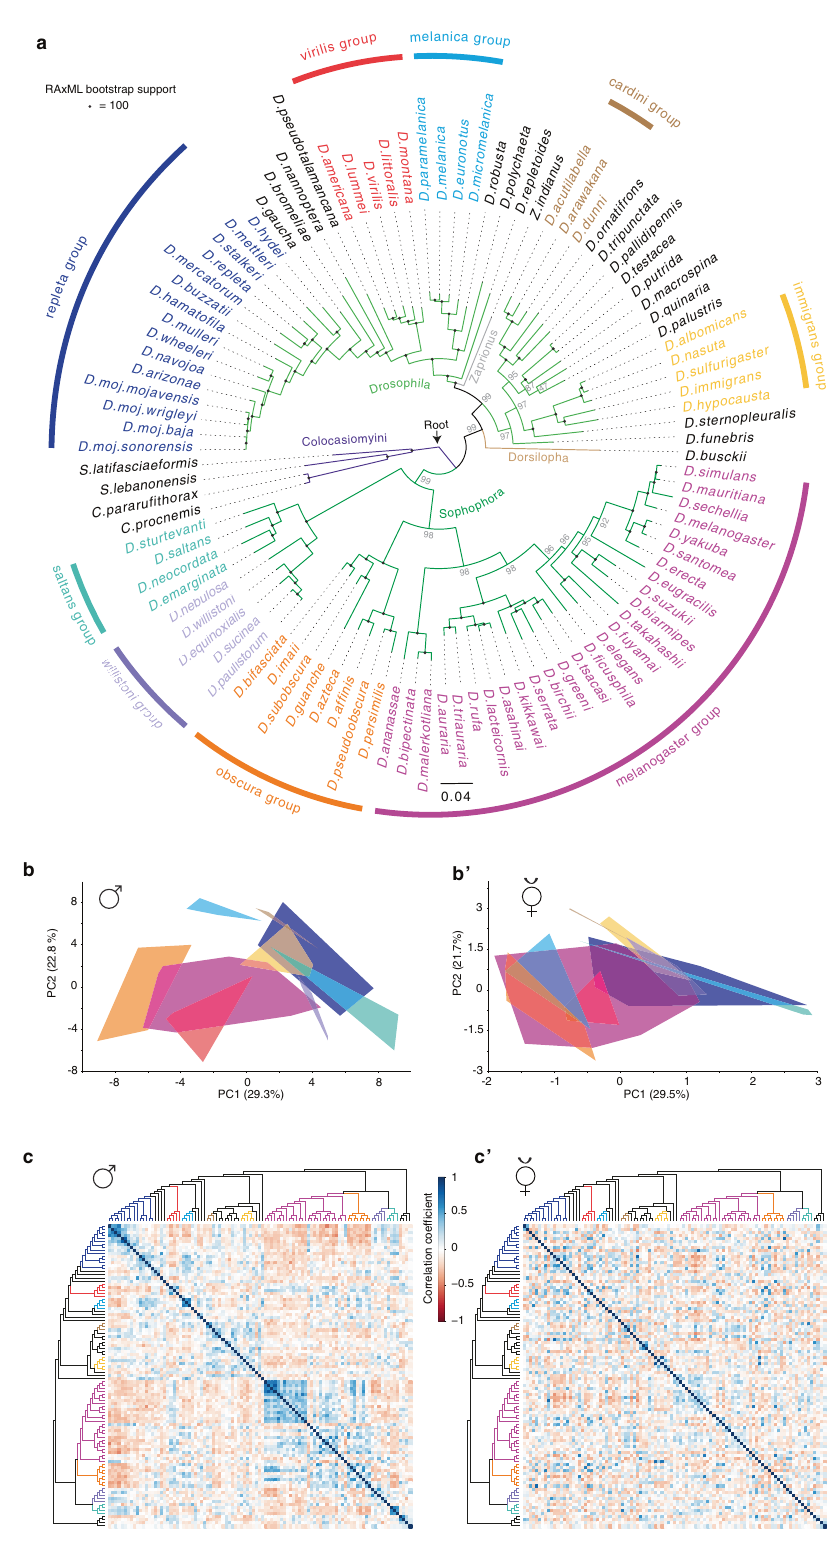
high correlation coef fi cients to chemical pro fi les of other male species of their own group, but negative correlation coef fi cients to chemical pro fi les of males of different groups (i.e., blue cells are frequently present around the diagonal) (Fig. 1c). However, female species generally display high correlation coef fi cients (>0.75) randomly to each other apart from their phylogenetic relationships (Fig. 1c ’ ). Likewise, measurement of the